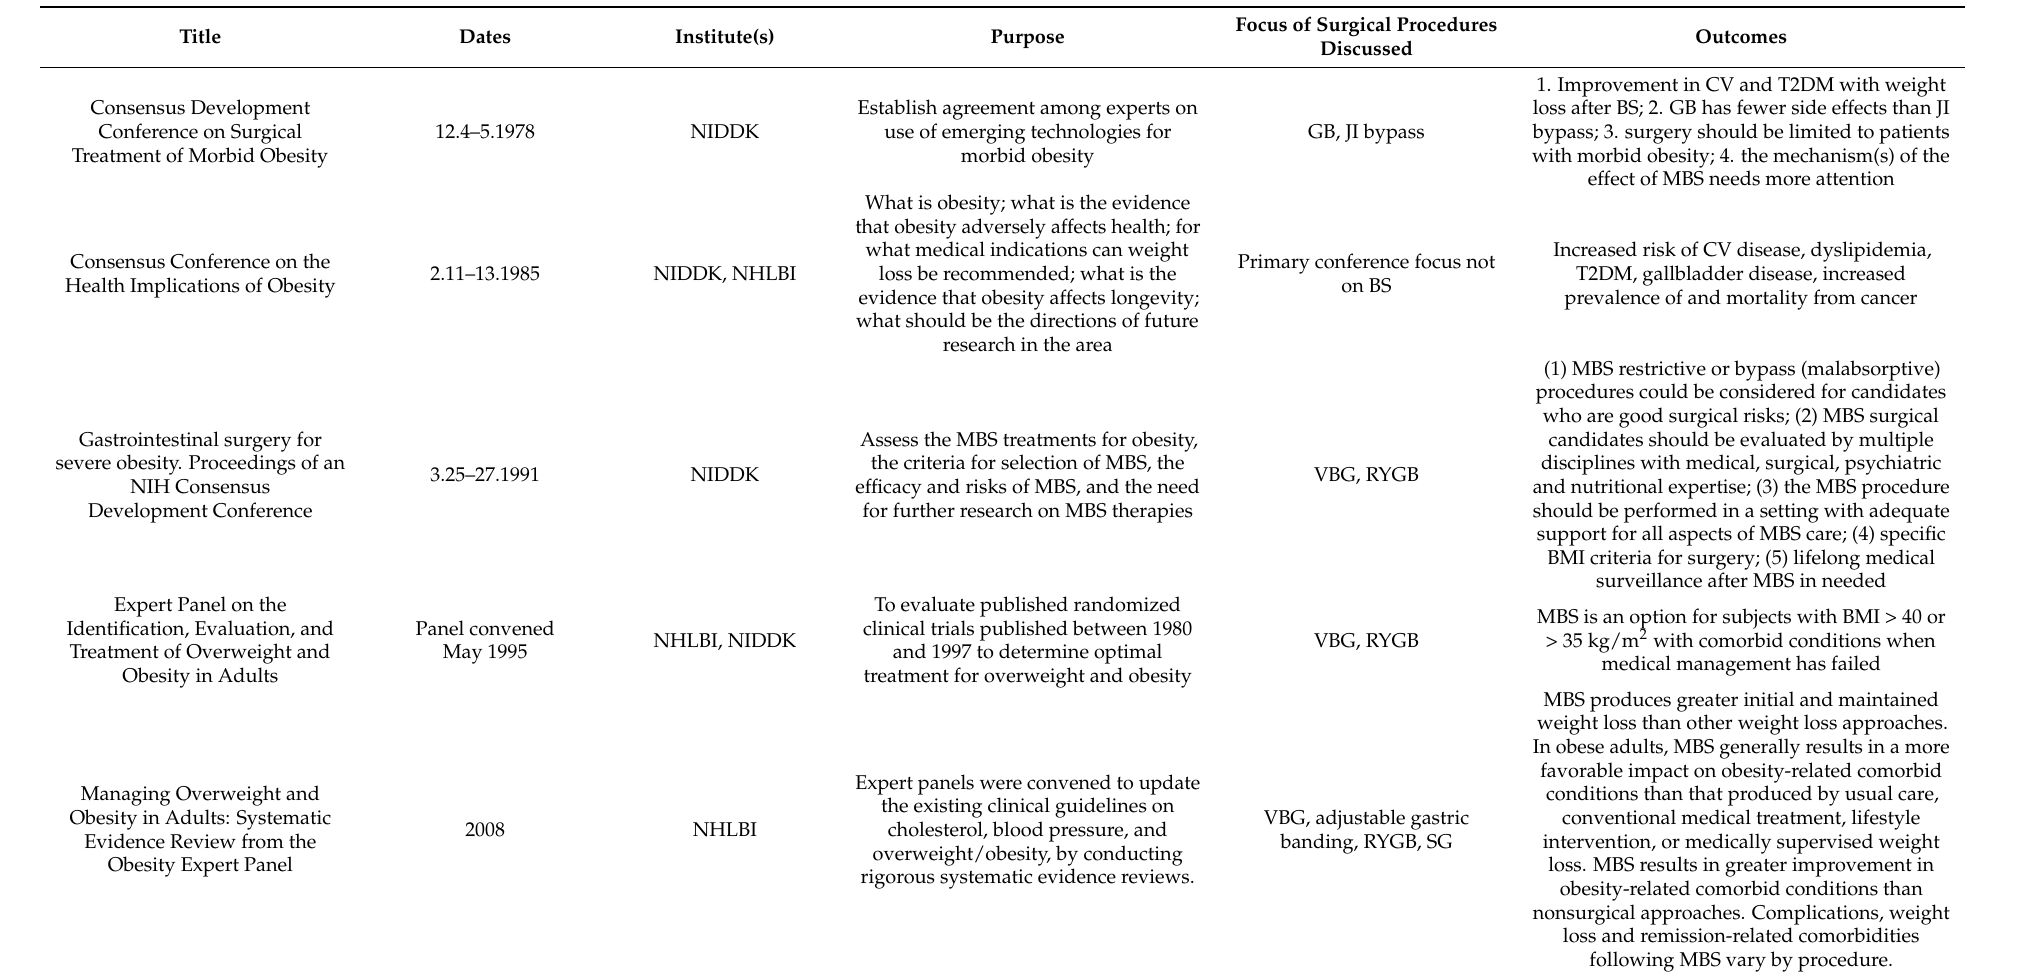
Table 1. The role of NIH in